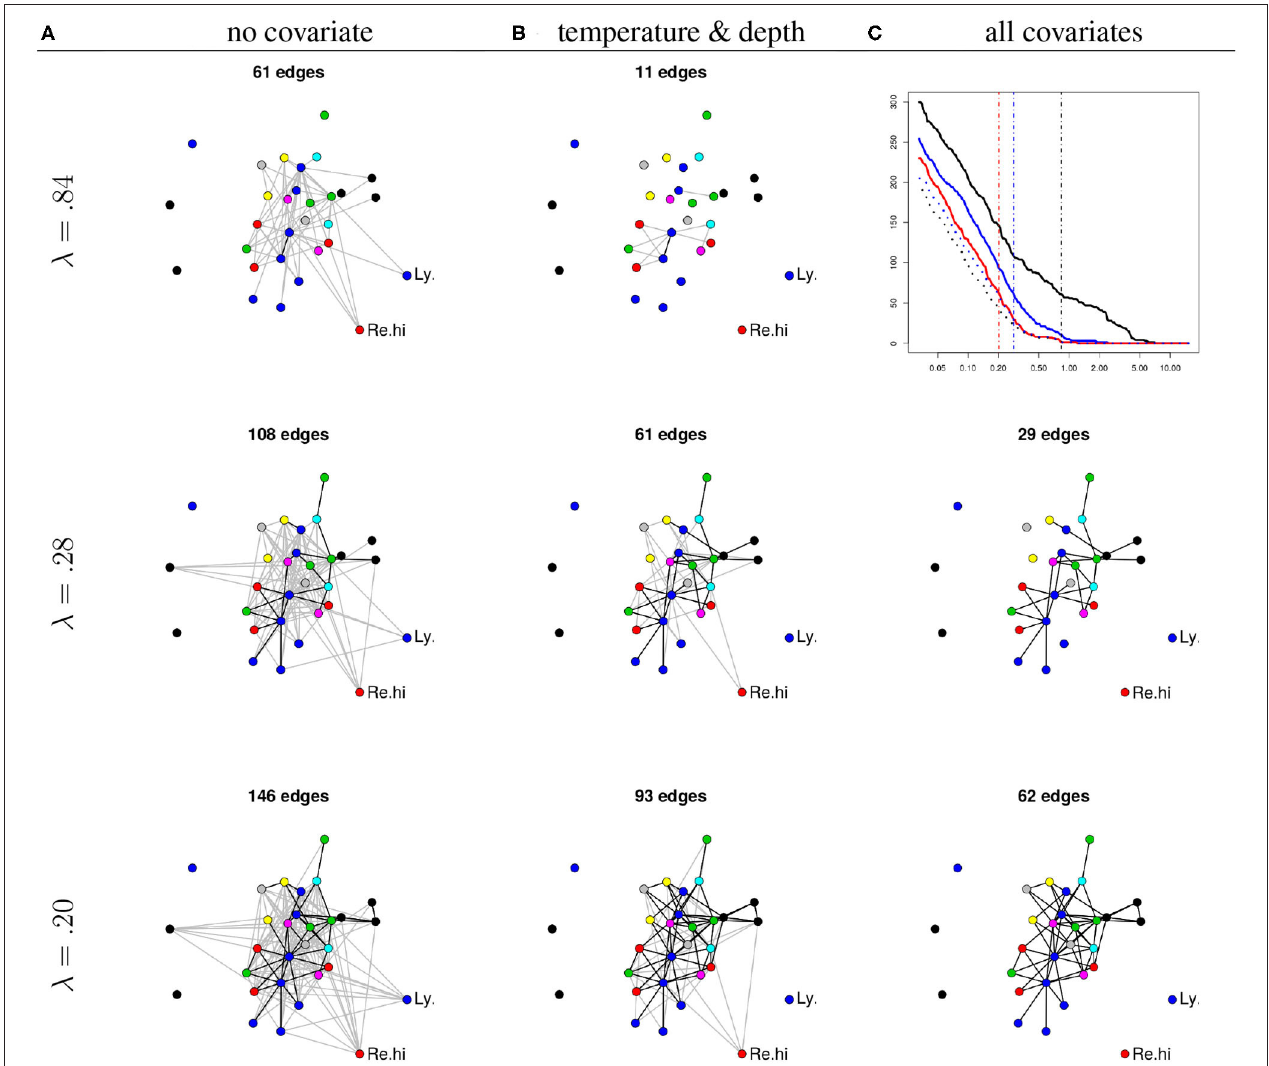
FIGURE 6 | (A) Networks inferred under the null model (no covariates). (B) Networks inferred using temperature and depth as covariates. (C) Networks inferred using all available covariates. All networks are inferred under increasing penalties (top: λ species. The position of the nodes are kept fixed. Node color: species family (see Fossheim et al., 2006). Black edges: edges in common with the network inferred with all covariates and same λ . The missing network (top right panel, all covariates and λ λ . Black: no covariate, blue: temperature and depth, red: all covariates, dotted black: common edges with no and all covariates, dotted blue: common edges between two and all covariates. Vertical dashed lines: the three chosen values of λ